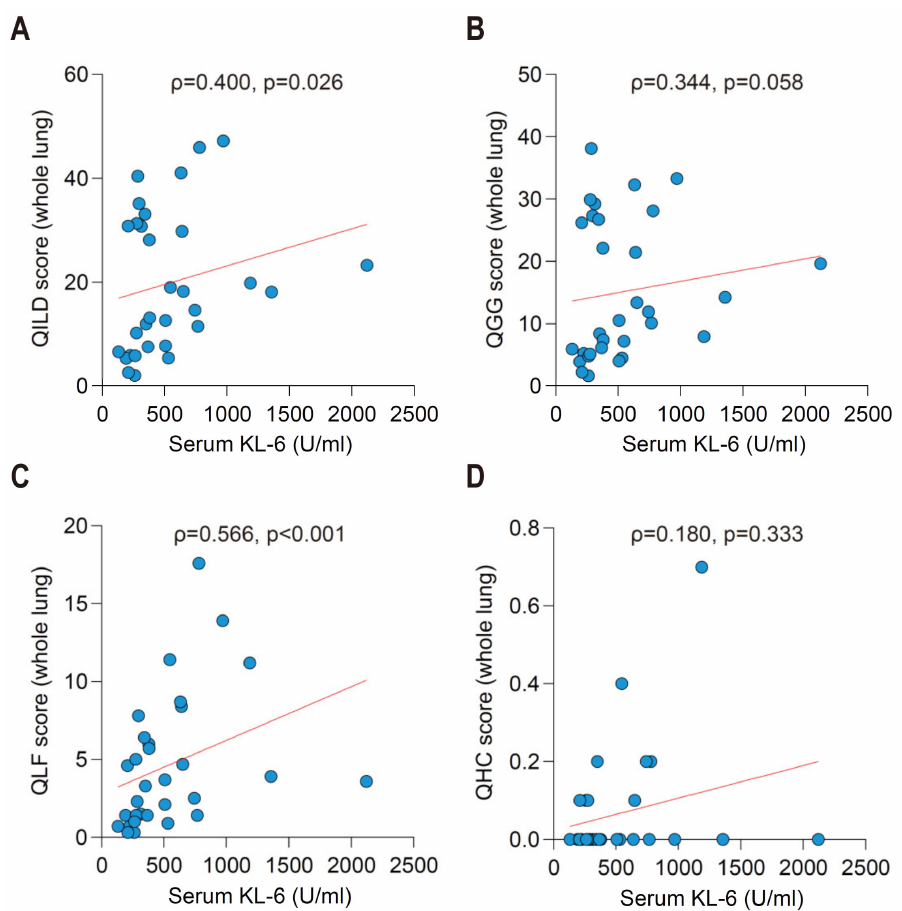
Figure 2. Quantitative correlation between QILD scores and serum concentration of KL-6 in the RA- ILD patients at baseline (cohort 2, n = 31). ( A ) QILD, ( B ) QGG, ( C ) QLF, ( D ) QHC. QGG, quantitative ground glass score; QLF, quantitative lung fibrosis score; QHC, quantitative honeycombing score. Intriguingly, we noticed a subgroup of patients with relatively higher QILD score than the majority of patients in the group with low level of KL-6, generally defined as 400 U/mL or lower (Figure 2A and Figure S3). Although statistically insignificant ( p = 0.120), the subgroup with evidently higher QILD score tended to have bronchiectasis as a comorbidity (7 out of 11 patients, 63.6%). When we explored individual cases with ( n = 4) and without ( n = 6) bronchiectasis, QILD scores were relatively higher in the patients with bronchiectasis (median 29.4 versus 13.2, respectively; p = 0.11) despite similar levels of KL-6 (median 346.2 versus 364.6 U/mL, respectively, p = 0.35). QLF scores were also relatively higher in the patients without bronchiectasis (median 4.7 versus 4.1, respectively; p = 0.76). Three representative analyses in the patients with or without bronchiectasis were shown (Figure 3A,B). Interestingly, geographic distribution of bronchiectatic lesion was concordant with condensed QLF dots, which were well described in the coronal plane of HRCTs. Therefore, QILD score may be able to detect bronchiectasis-associated interstitial changes that are not reflected in elevated levels of serum